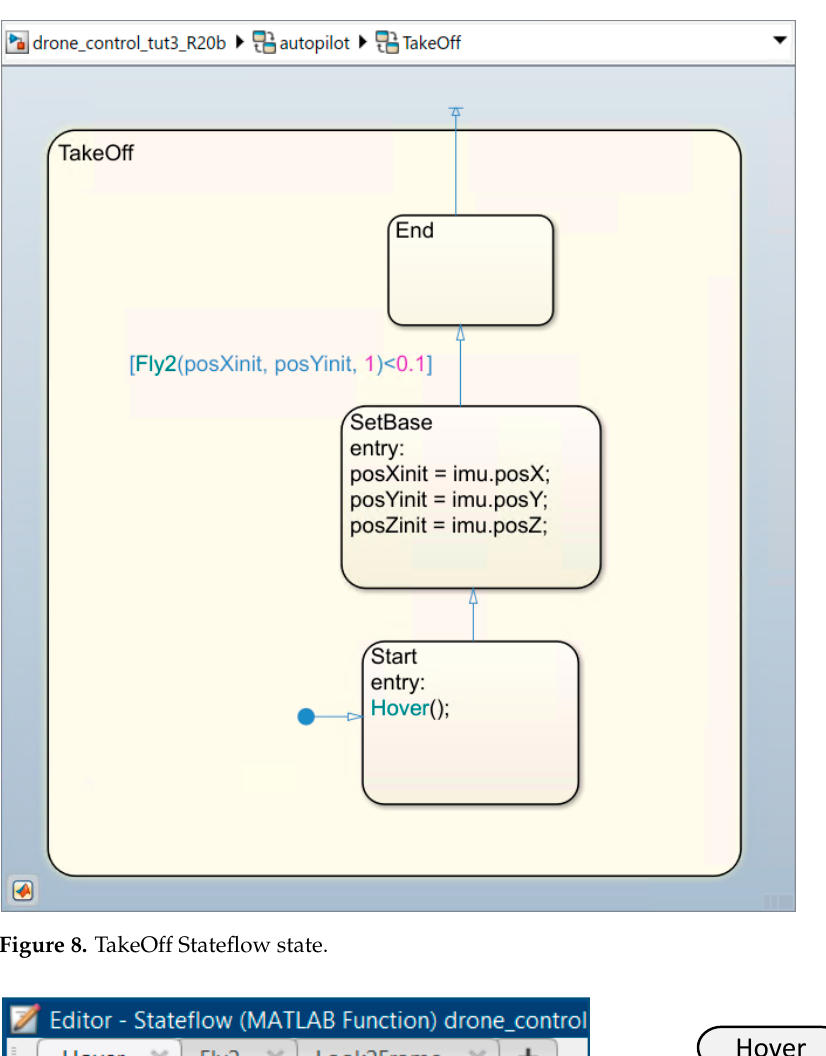
Figure 8. TakeOff Stateflow state.